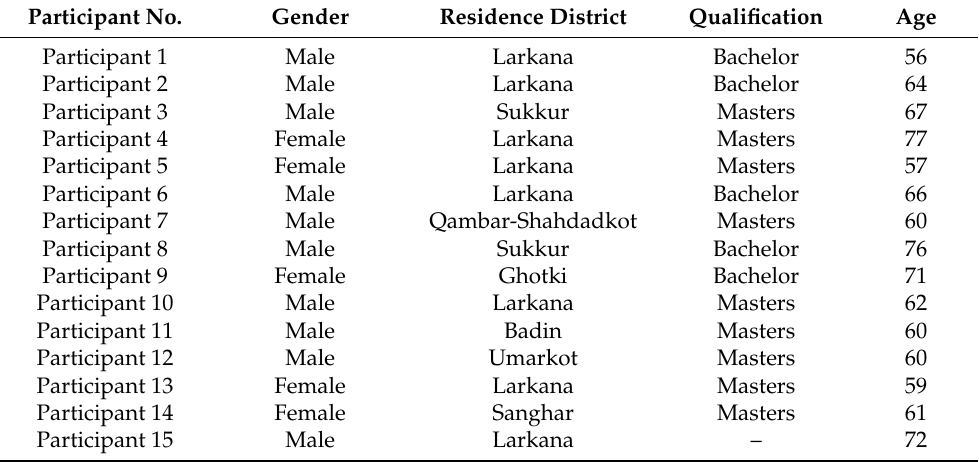
Table 1. Participants’ background information.